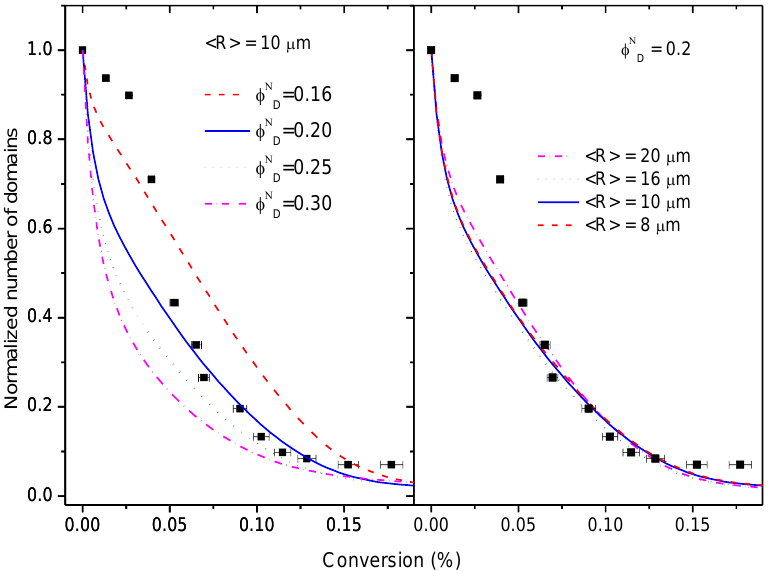
Figure 6. Normalized number of domains as a function of conversion: lines are simulations, square points are experimental data. Left: fixed initial radius of domains at 10 µ m and simulations for several